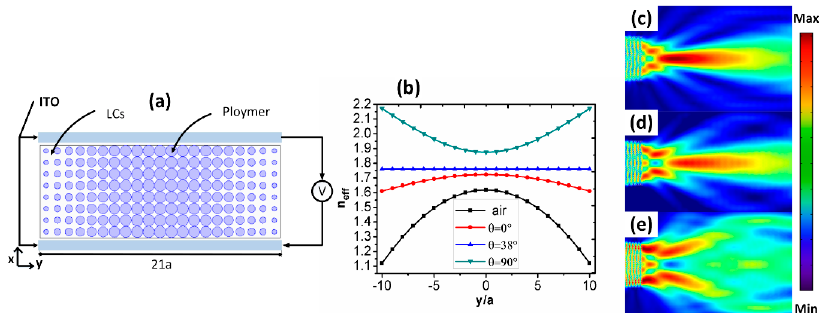
Figure 4. ( a ) The schematic of electrically tunable micro-lens. ( b ) Effective refractive index distribution with different background of air or LCs with the various of the rotation angles. The electric field intensities of micro-lens with rotation angle of ( c ) θ = 0° ( d ) θ = 38° ( e ) θ = 90°.